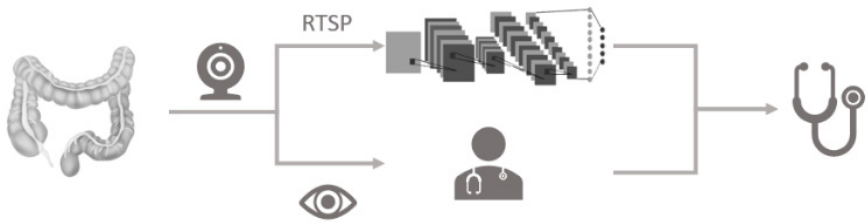
Figure 4. The concept of the polyp identification framework.